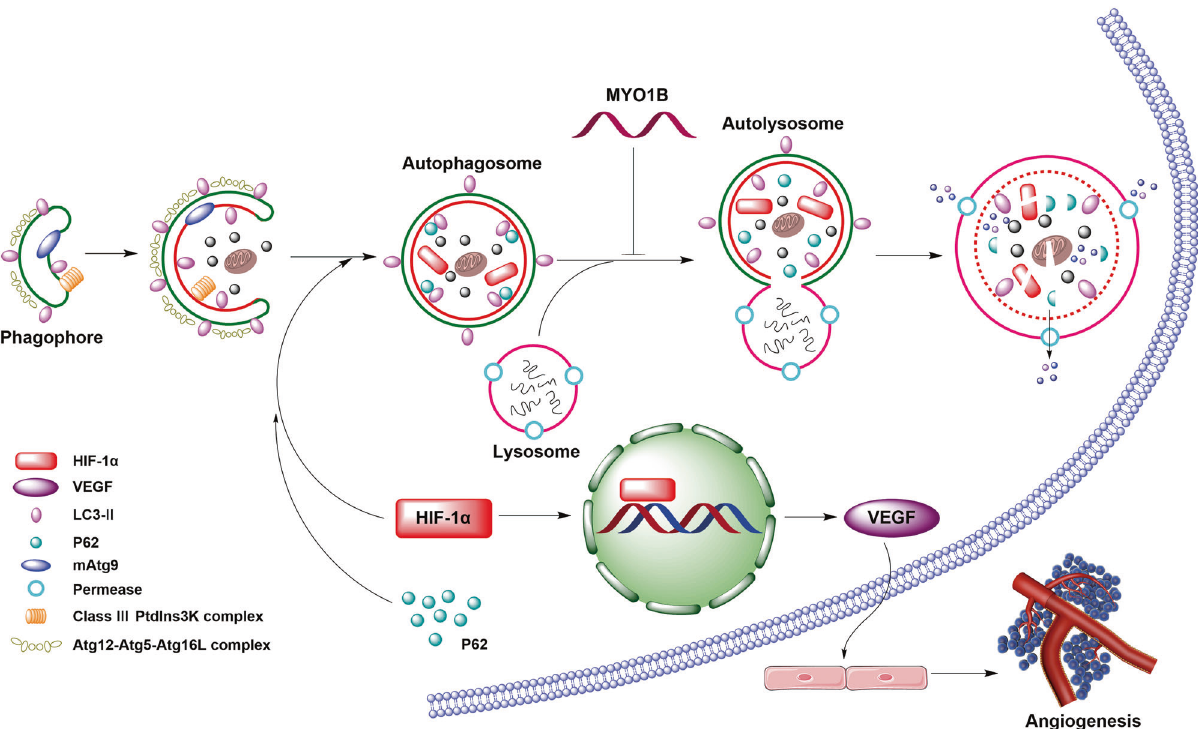
Fig. 7 Schematic diagram of the mechanism on Myo1b mediated autophagy and angiogenesis in CRC. The high-expression of Myo1b in CRC cells disrupts the fusion between autophagosomes and lysosomes, which blocks the selective degradation of HIF-1 α . The accumulated HIF-1 α further upregulates the proangiogenic related genes and consequently promotes angiogenesis in